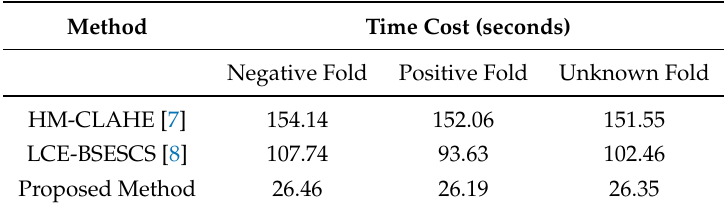
Table 5. Time cost of prior and proposed contrast